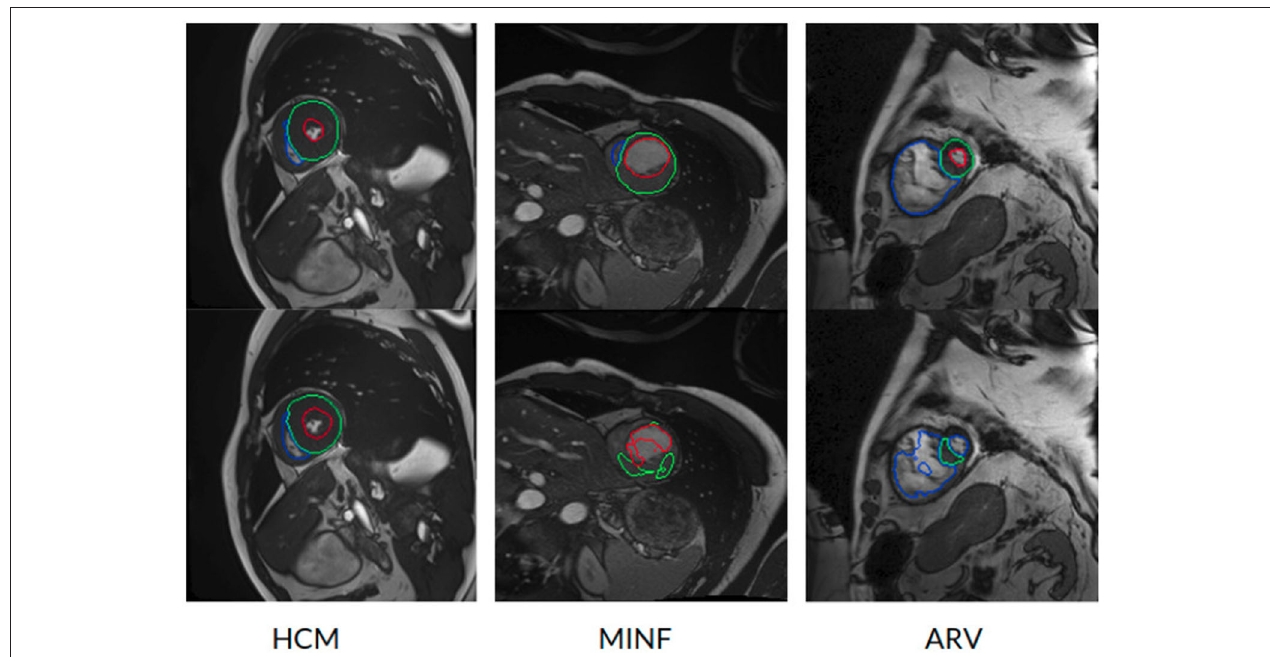
FIGURE 4 | Examples of the worst cases that have pathological deformations. Row 1: Ground truth; row 2: predicted results by the UKBB model. HCM, hypertrophic cardiomyopathy; MINF, myocardial infarction with altered left ventricular ejection fraction; ARV, abnormal right ventricle. Column 1 shows that the UKBB model underestimates the myocardium in patients with HCM. Column 2 shows that the model struggles to predict the cardiac structure when certain sections of the myocardium are extremely thin. Column 3 shows a failure case where an extremely large right ventricle is shown in the image. All these images are from ACDC